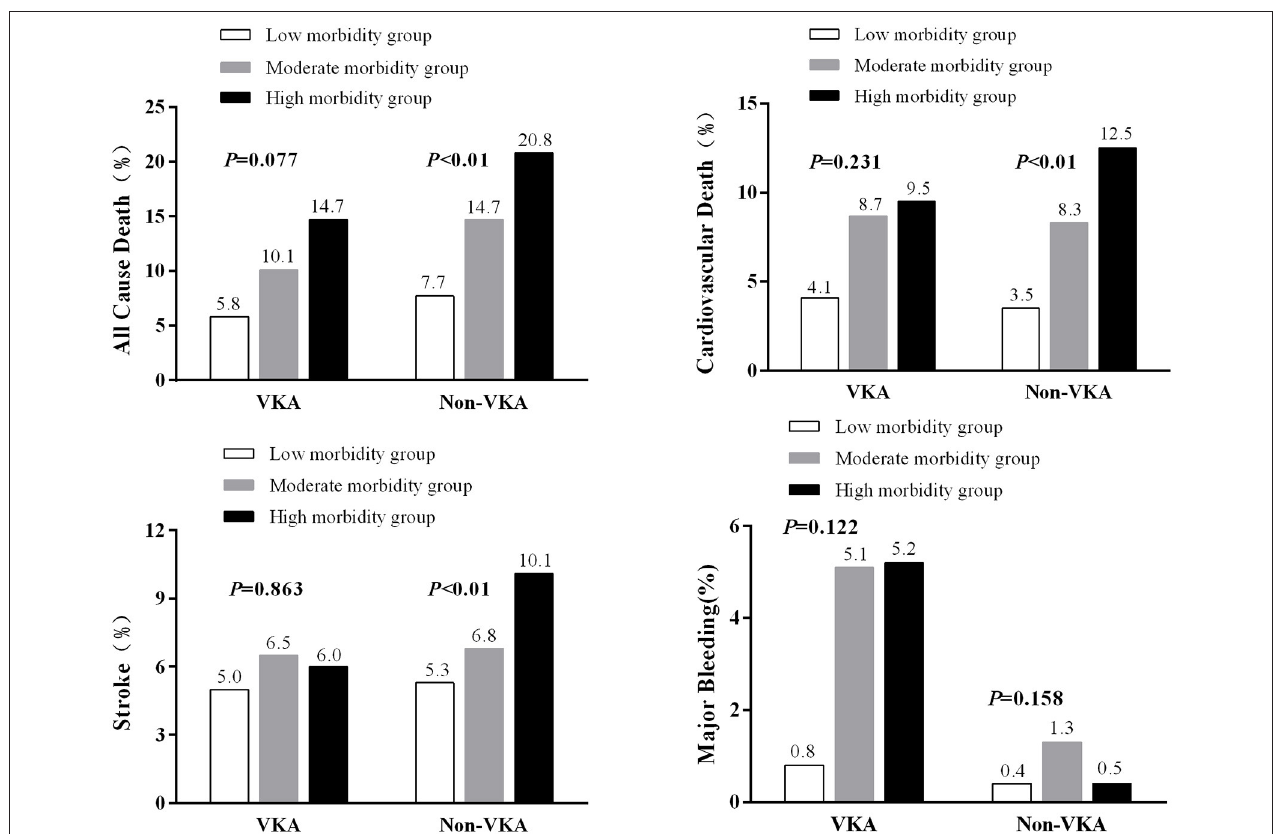
FIGURE 1 | Event rates of outcome variables in patients with AF by morbidity categories and with or without VKA